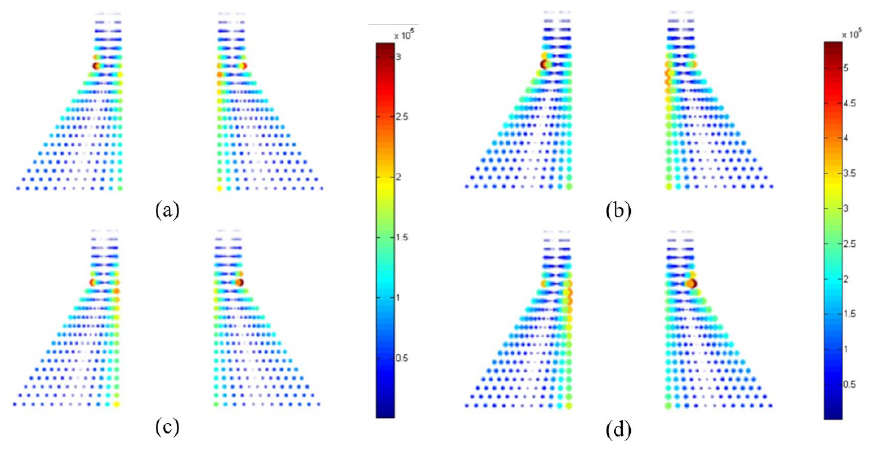
Figure 10. The envelope of the maximum normal vertical stresses of tension (a, b) and compression (c, d) in the gravity structures of the lock for the (a, c) uncoupled structural and (b, d) coupled fluid-structure cases, in